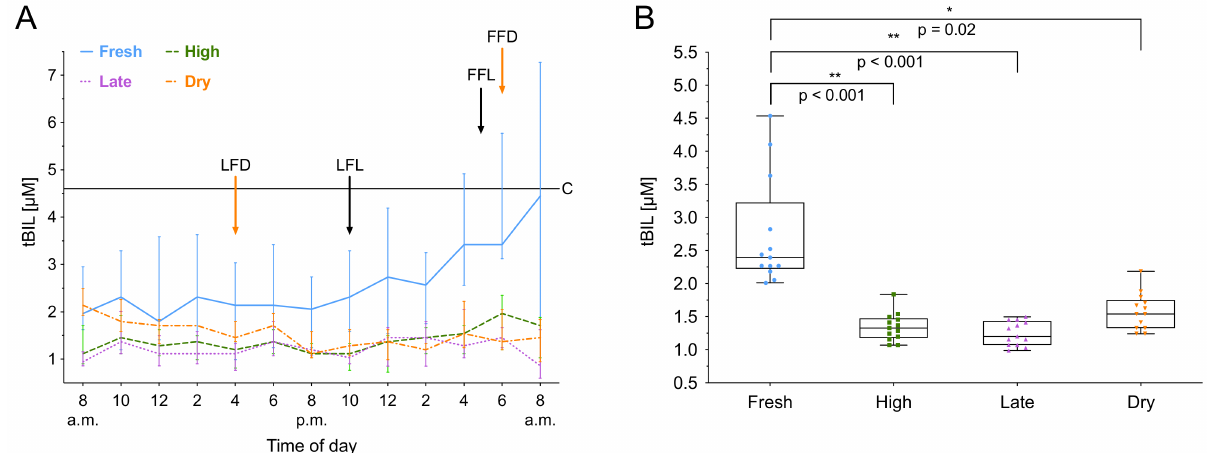
Figure 4. Total bilirubin (tBIL) concentration in serum over 24 h. ( A ) Data expressed as group median with the interquartile range as error bars. Last and first feeding of the day and cut off level for group investigations [9] are shown. Black color indicates lactating cows, orange represents dry cows. LFL: last feeding of lactating cows; FFL: first feeding of lactating cows; LFD: last feeding of dry cows; FFD: first feeding of dry cows; C: Cut off level for all cows. ( B ) Within-group distribution of tBIL concentration in serum over 24 h. The box depicts the median and the lower and upper quartile. The whiskers show minimum and maximum values. Brackets represent Tukey adjusted pairwise comparisons between lactation group